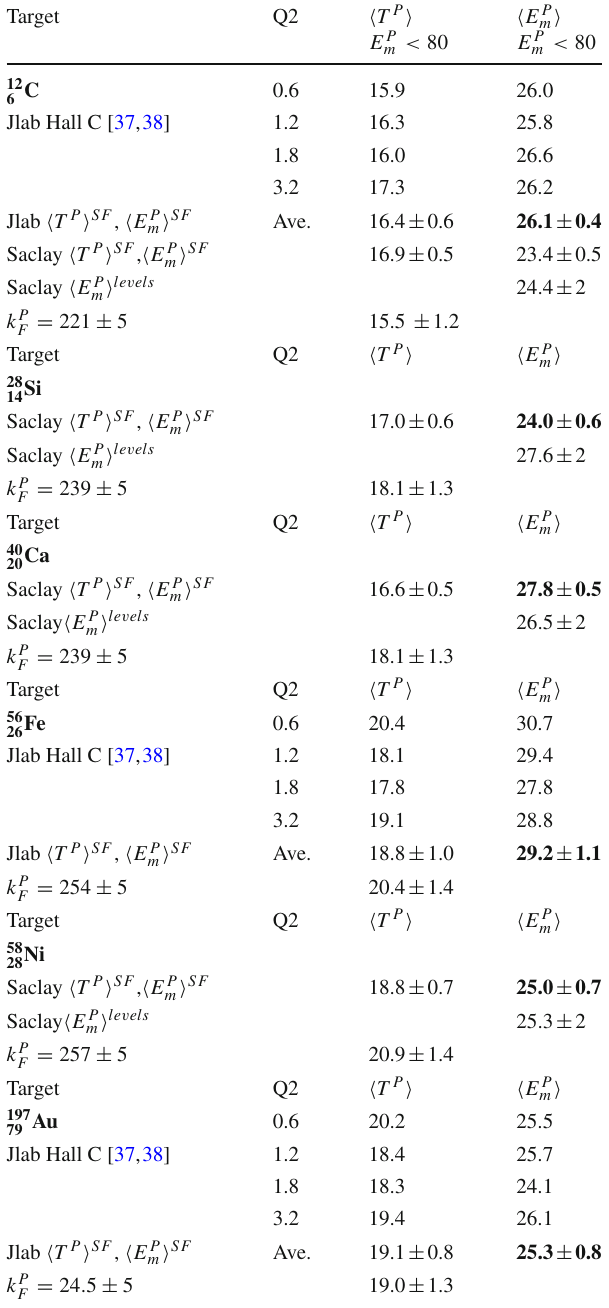
Table 3 Average values of the proton kinetic energy (cid:5) T P (cid:6) SF and miss- ing energy (cid:5) E P m (cid:6) SF for 1p1h final states ( E P m < 80) extracted from published tests of the Koltun sum rule using spectral function (SF) measurements at Jefferson lab Hall A [37,38] and Saclay [39,40]. For ( k P ) 2 All energies are in MeV. The a Fermi gas distribution (cid:5) T P (cid:6) = 3 F 5 bolded numbers are the best estimates for each